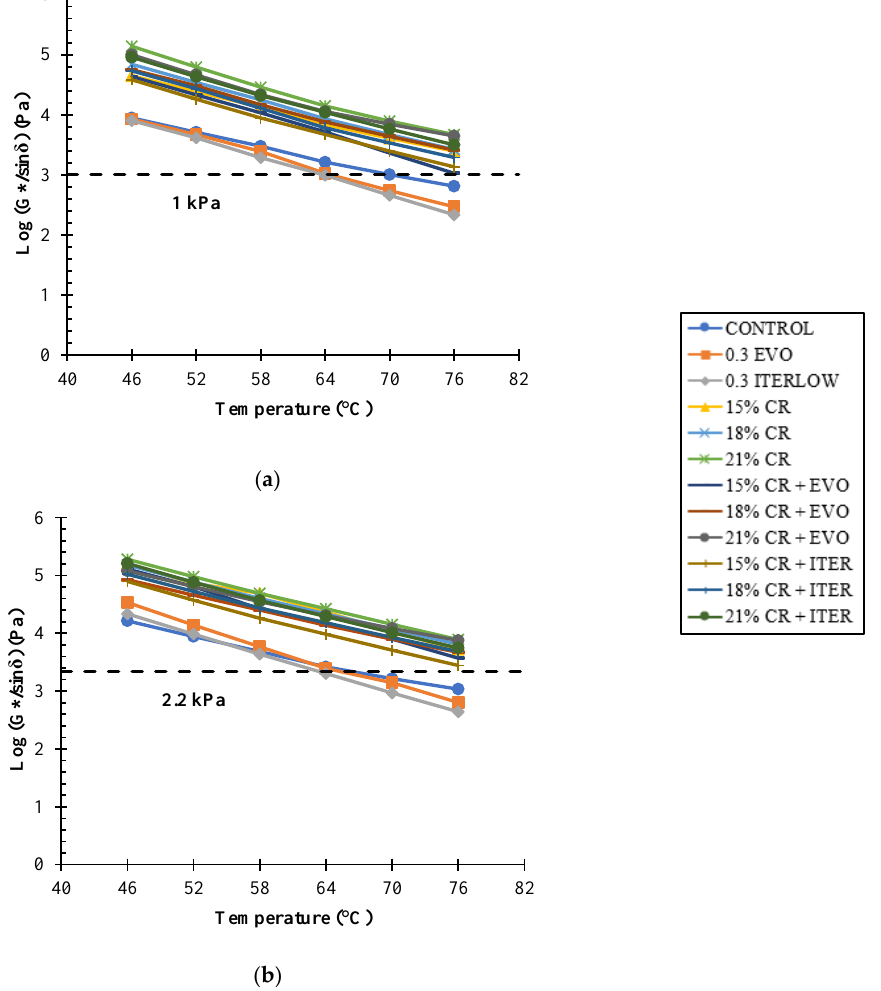
Figure 10. Log ( G */sin δ ) vs. temperature for: ( a ) unaged; ( b ) RTFO aged samples.